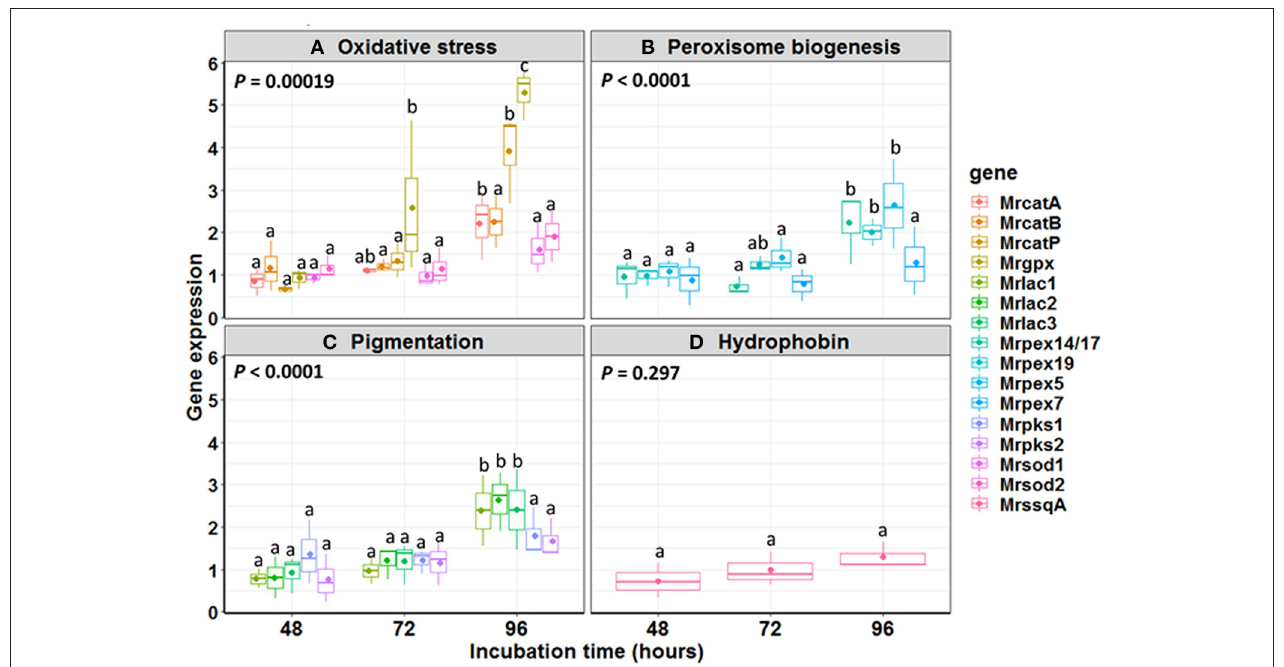
FIGURE 5 | Relative expression ratio of genes involved in (A) oxidative stress, (B) peroxisome biogenesis, (C) pigmentation, and (D) hydrophobin during Metarhizium robertsii microsclerotial differentiation. The boxes include 25–75% of the values; the line inside the boxes is the median (50%) of the distribution of all values, and the vertical bars represent the non-outlier range. Mean values are indicated by dots inside each boxplot. Mean comparisons were made between time intervals within each gene class, and different letters highlight significant differences between the gene expression. Significance level used: α = 0.05 according to Tukey HSD